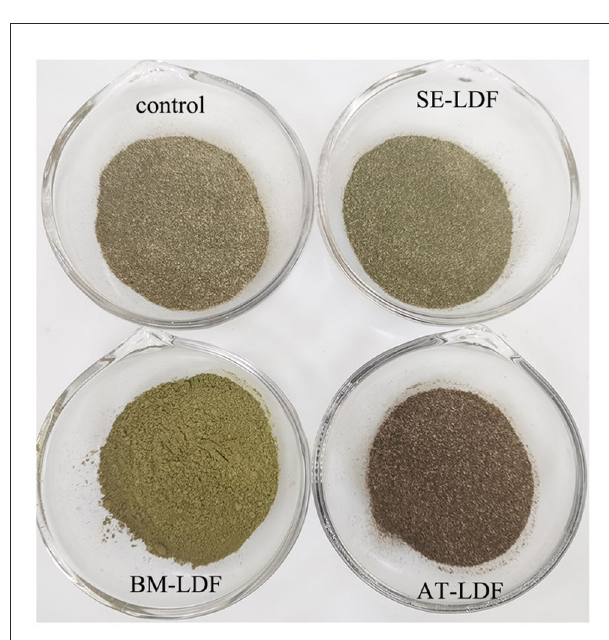
FIGURE4 Real pictures of control, SE-LDF, BM-LDF, and AT-LDF. Control: lotus leaves dietary fiber. SE-LDF, shear emulsifying modified lotus leaves dietary fiber; BM-LDF, ball milling modified lotus leaves dietary fiber; AT-LDF, autoclave modified lotus leaves dietary fiber.